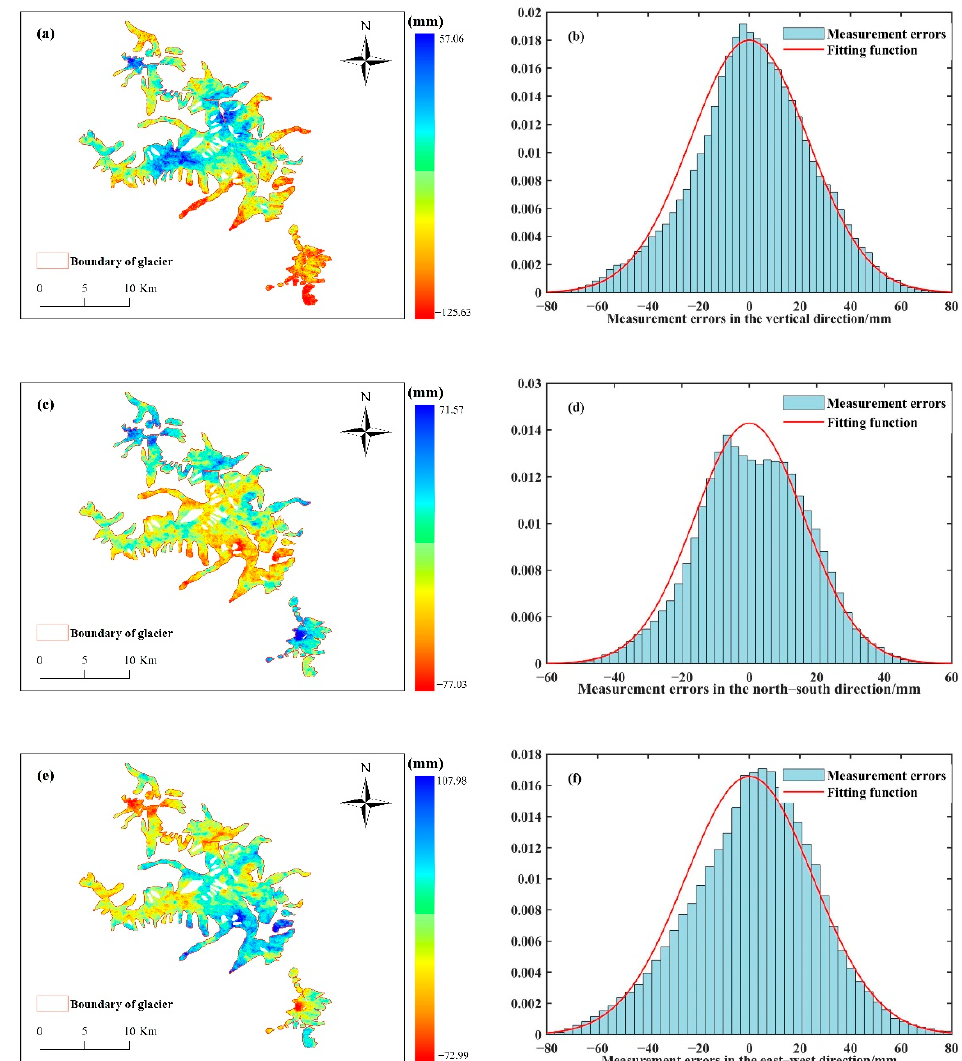
Figure 6. Three-dimensional deformation field of the Meili Mountain glacier, ( a ) vertical component, ( b ) measurement errors in the vertical direction, ( c ) north–south component, ( d ) measurement errors in the north–south direction, ( e ) east–west component, ( f ) measurement errors in the north–south direction.